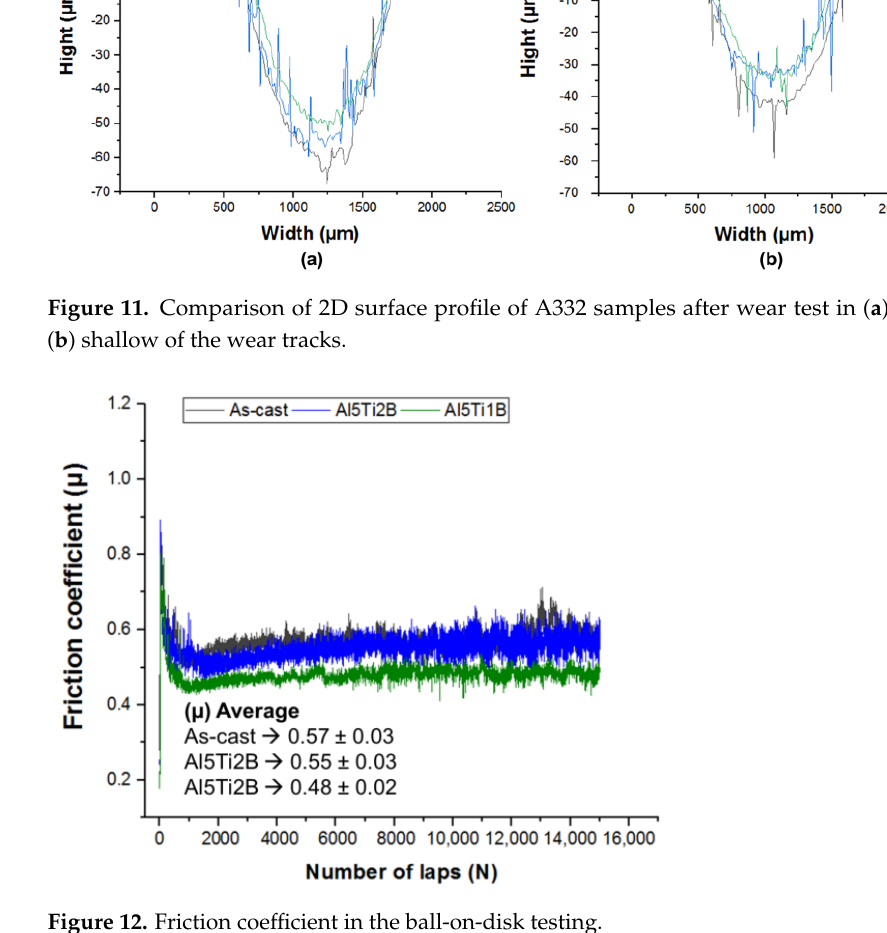
Table 4. Relative wear resistance.